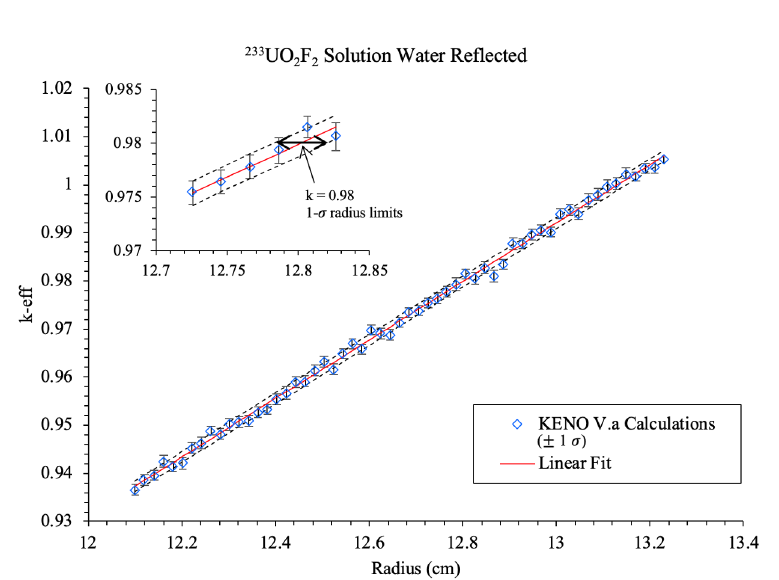
Figure 1. Example of Linear Fit and Uncertainty